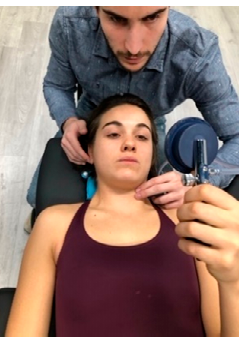
Figure 1. Deep neck flexor . Subjects were instructed to “gently nod their head as though they were saying ‘yes’”. Contribution from the superficial muscles was monitored using observation and palpation. Then, the subjects were taught to perform a slow and controlled deep neck flexor exer-